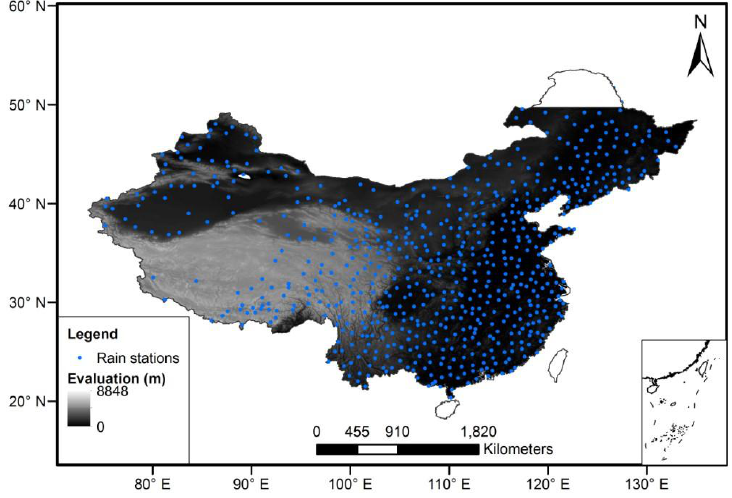
Figure 1. Elevation over Mainland China and location of 596 meteorological